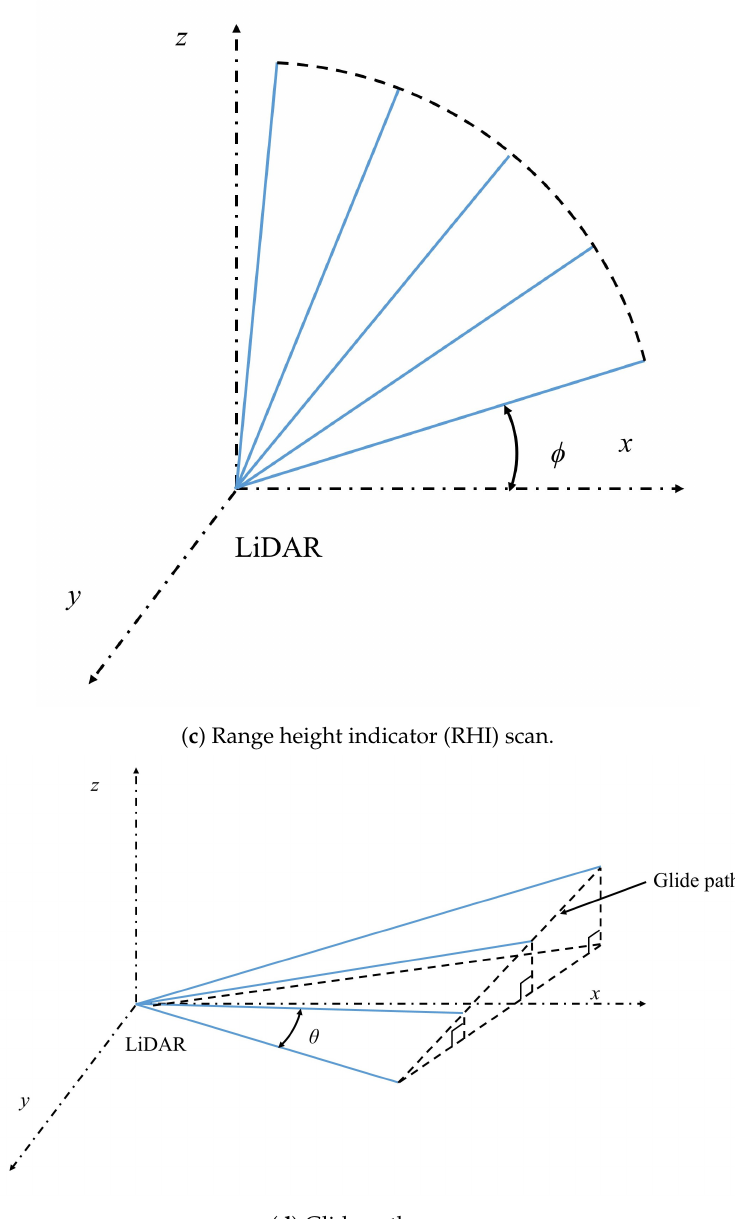
Figure 3. Schematic diagrams of scan patterns in one degree of freedom (DOF). LiDAR is placed at the origin of the Cartesian coordinate